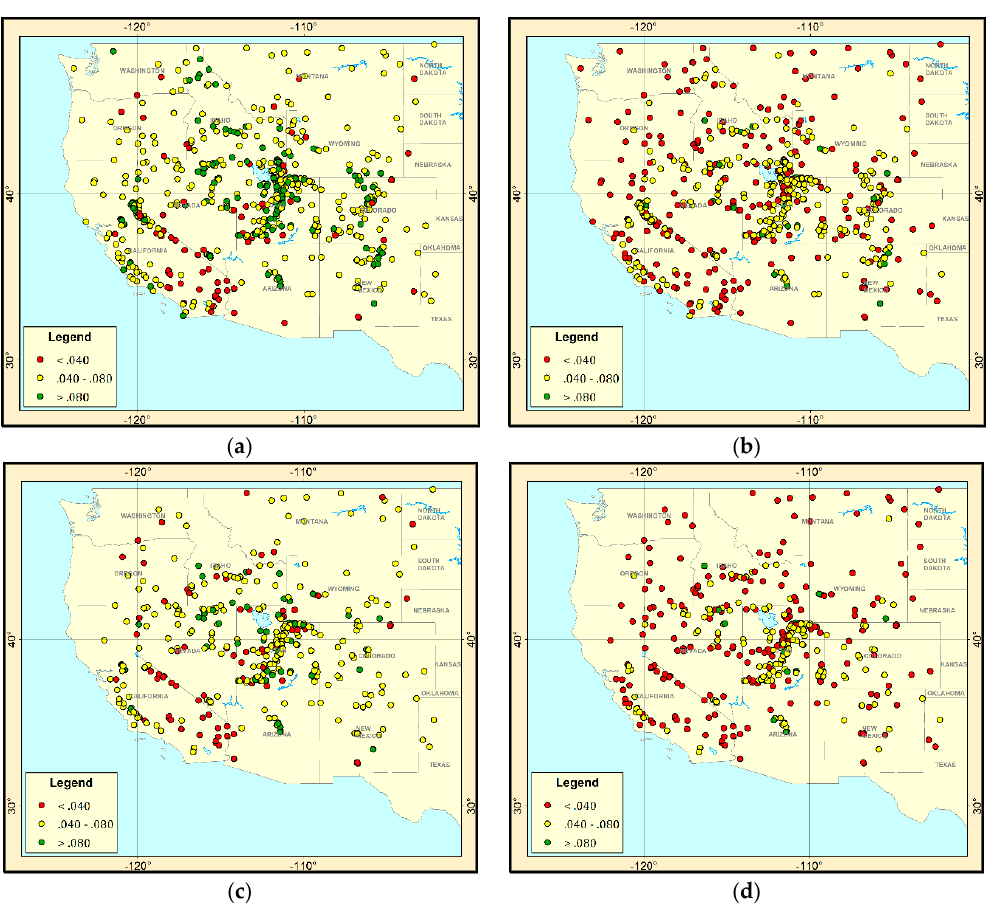
Figure 5. Spatial distribution of ubRMSE between the site-specific SSM and original ( a , c ) and fused ( b , d ) SMAP SSM over each station using “sm_sat-whole” ( a , b ) and “sm_sat-rcmd” ( c , d ). From Figures 4 and 5, a general increase in R value and a decline in ubRMSE can be seen, with nearly all points for R becoming red (better) and nearly half the points for ubRMSE turning red